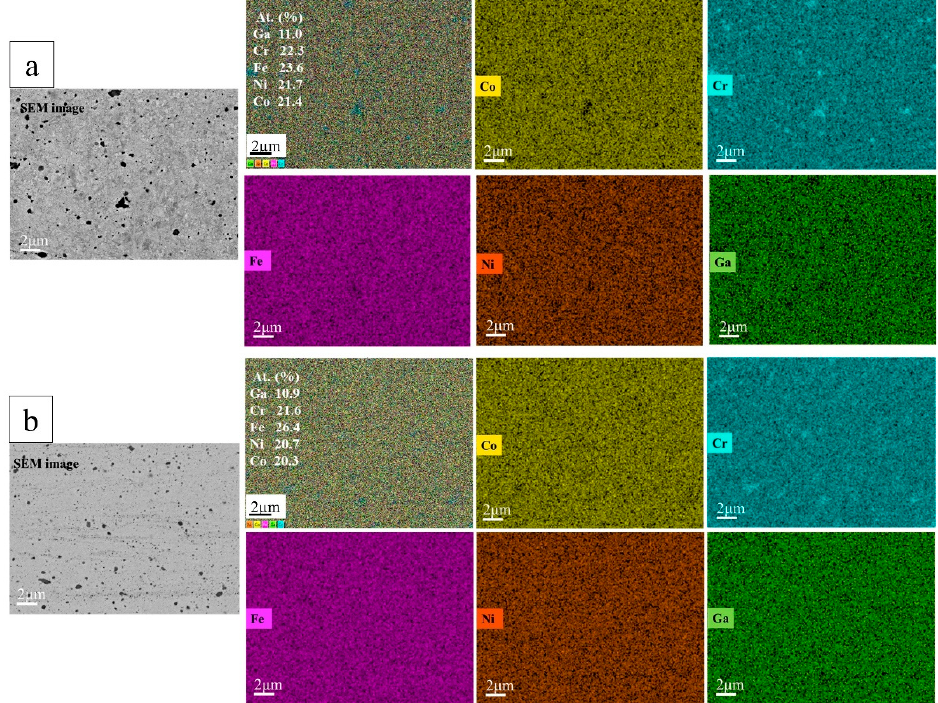
Figure 3. SEM images and EDX-mapping of a cross-section of bulk CoCrFeNiGa 0.5 HEAs ( a ) sintered from HEBM powder blend by SPS at 1073 K ( b ) after subsequent HPT treatment.